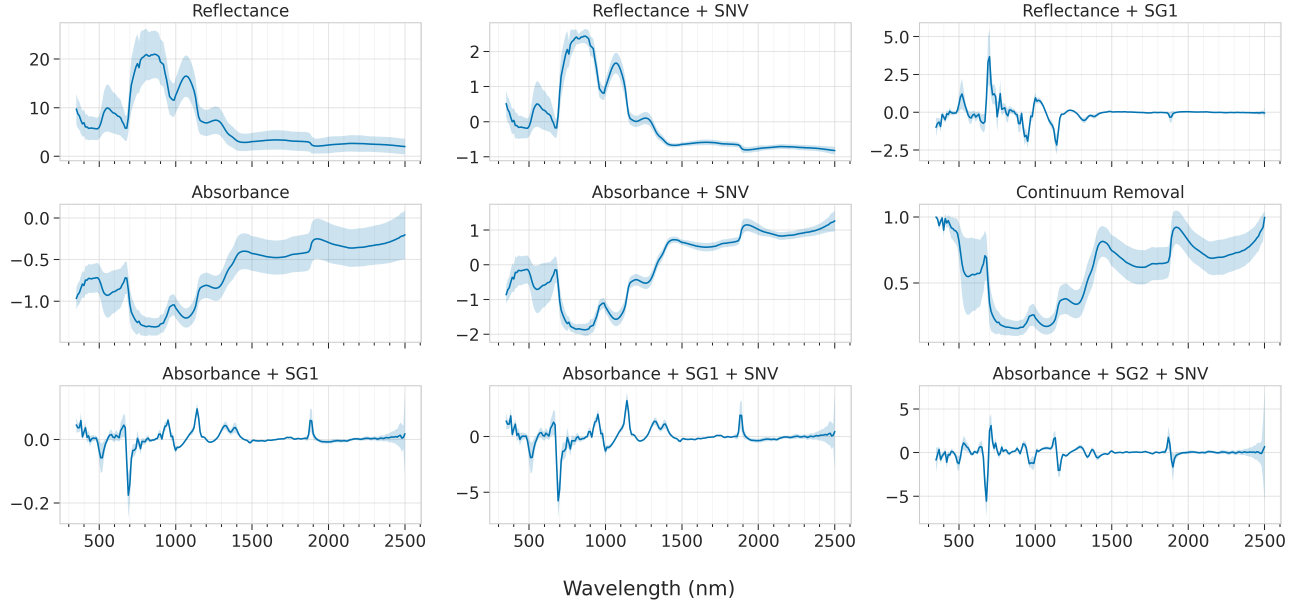
Figure 8. The effect of the various pre-treatments on the mean spectra (across all varieties); the shaded area indicates the standard